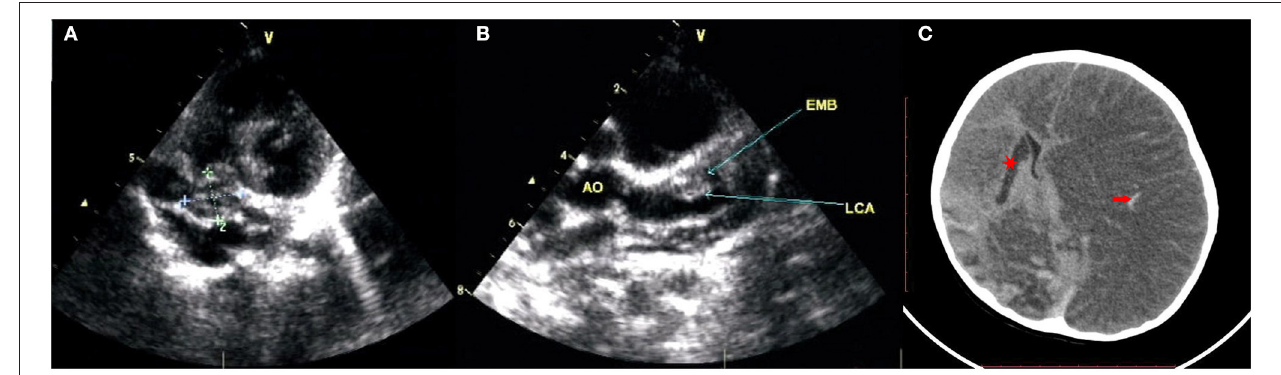
FIGURE 1 | The echocardiography revealed extensive CAA and CAT. (A) Right coronary artery aneurysms sized 9mm and thrombosis sized 19mm × 14mm; (B) left anterior descending artery aneurysms sized 11mm and thrombosis sized 11 × 9mm, left circumflex coronary artery aneurysms sized 14mm. (C) The brain CT showed cerebral infarction of right basal ganglion (red star), hemorrhagic stroke involved in an entire left cerebral area with obviously secondary cerebral swelling, edema (red